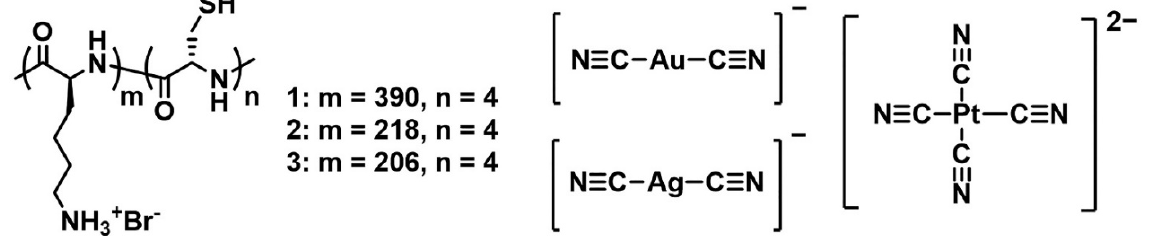
Figure 1. Molecular structures of the diblock copolypeptide amphiphiles Lys 390 - b -Cys 4 ( 1 ), Lys 218 - b - Cys 4 ( 2 ), and Lys 206 - b -Cys 4 ( 3 ), and of the cyanometallate complexes [Au(CN) 2 ] − , [Ag(CN) 2 ] − , and [Pt(CN) 4 ] 2− .